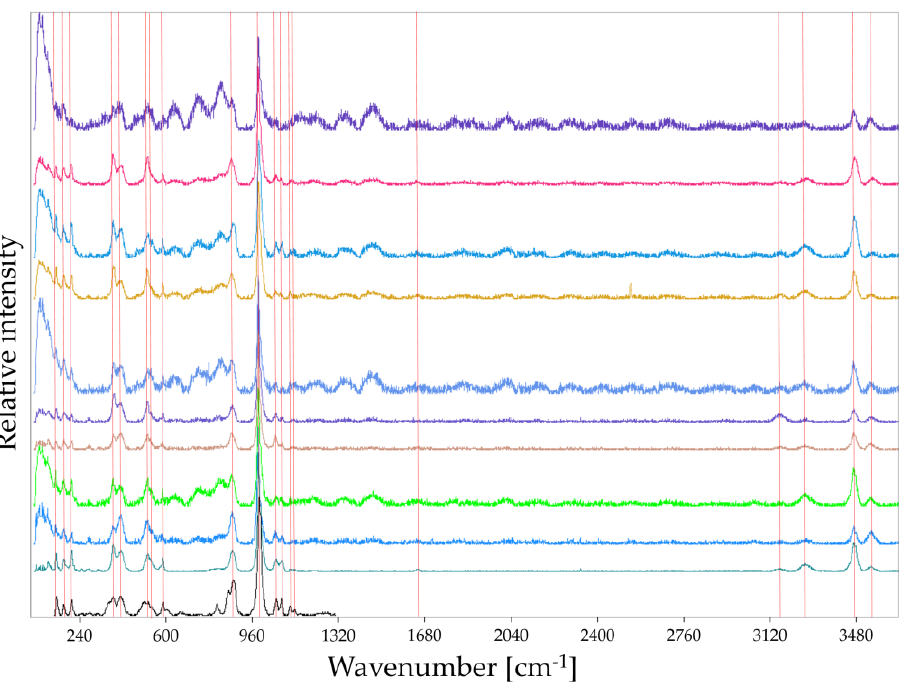
Figure 8. Precipitate analysis via RAMAN spectroscopy. All sample data were background corrected using Crystal Sleuth software provided by the RRUFF Project [45]. Raman scans of brushite taken from the RRUFF Database (black line, RRUFF ID: R070554), positive sample (petrol, Carl Roth GmbH & Co. KG, Karlsruhe, Germany), precipitates at 6 V (blue), 8 V (green), 9 V (brown), 10 V (purple), 11 V (deep blue), 12 V (orange), 14 V (pale blue), 15 V (red) and 16 V (deep purple). Vertical red lines show matching peaks with database sample and positive sample. Experiments were carried out in triplicate and typical spectra are shown.